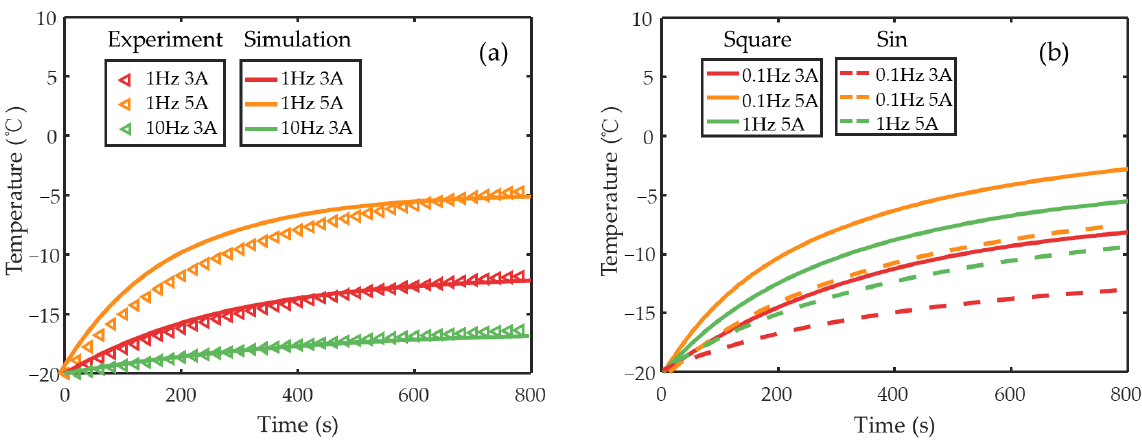
Figure 5. ( a ) Experimental and simulation results of preheating with SWAC; ( b ) experimental tem- perature evolution of the battery heated by alternating current with square and sinusoidal waveform.